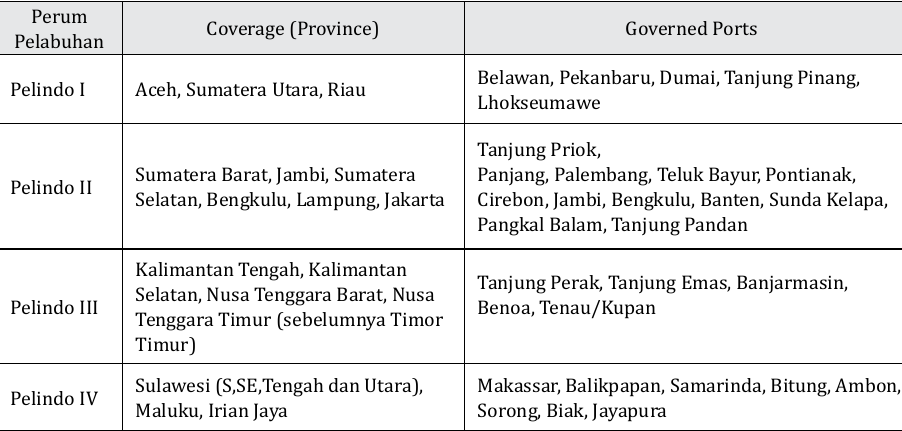
Table 1. Pelindo: Geographical